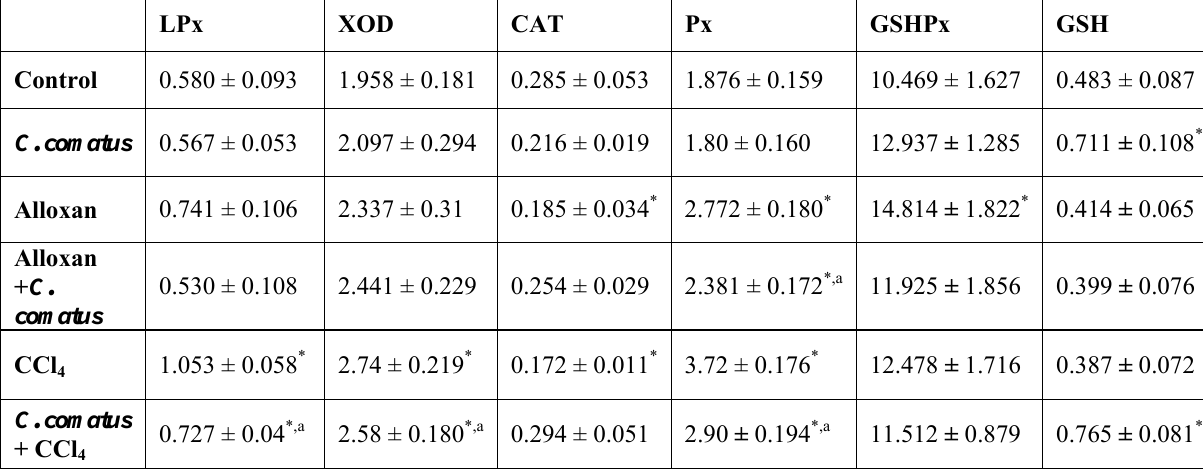
Table 1. Effect of Coprinus comatus aqueous suspension on liver biochemical